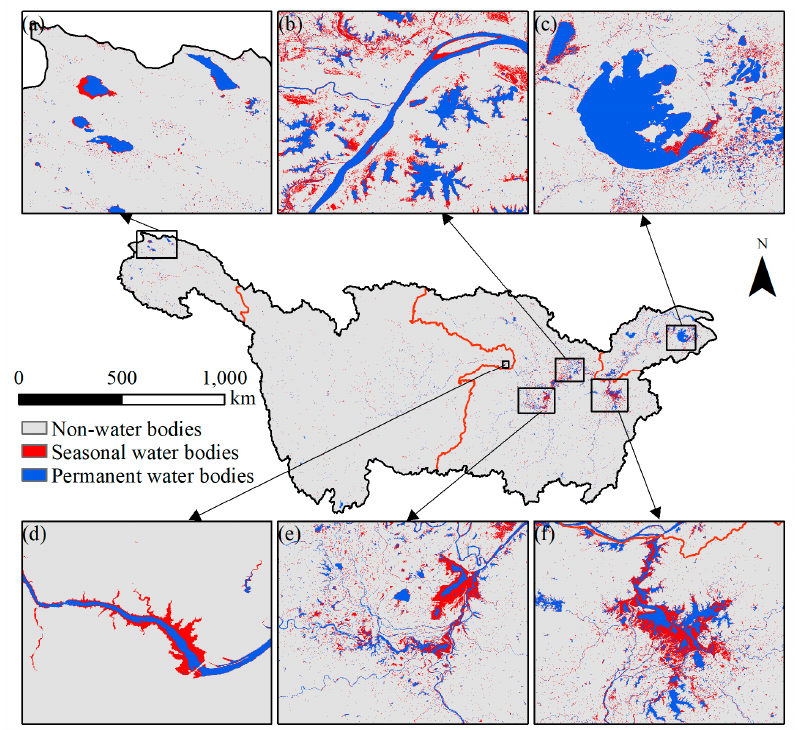
Figure 6. The spatial distribution of open-surface water bodies from 1984 to 2018 in the YRB. ( a – f ) indicates the source regions of the YRB, Wuhan city, Taihu Lake, the Three Gorges Dam (TGD), Dongting Lake, and Poyang Lake, respectively. Table 2. The area of open-surface water bodies from 1984 to 2018 in the YRB. Seasonal Water Bodies (km 2